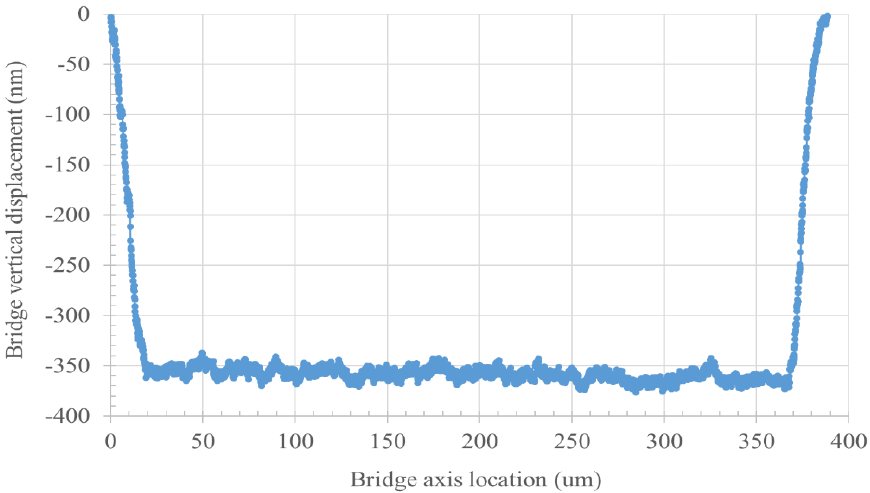
Figure 5. mechanical profile of a bent aluminum bridge.